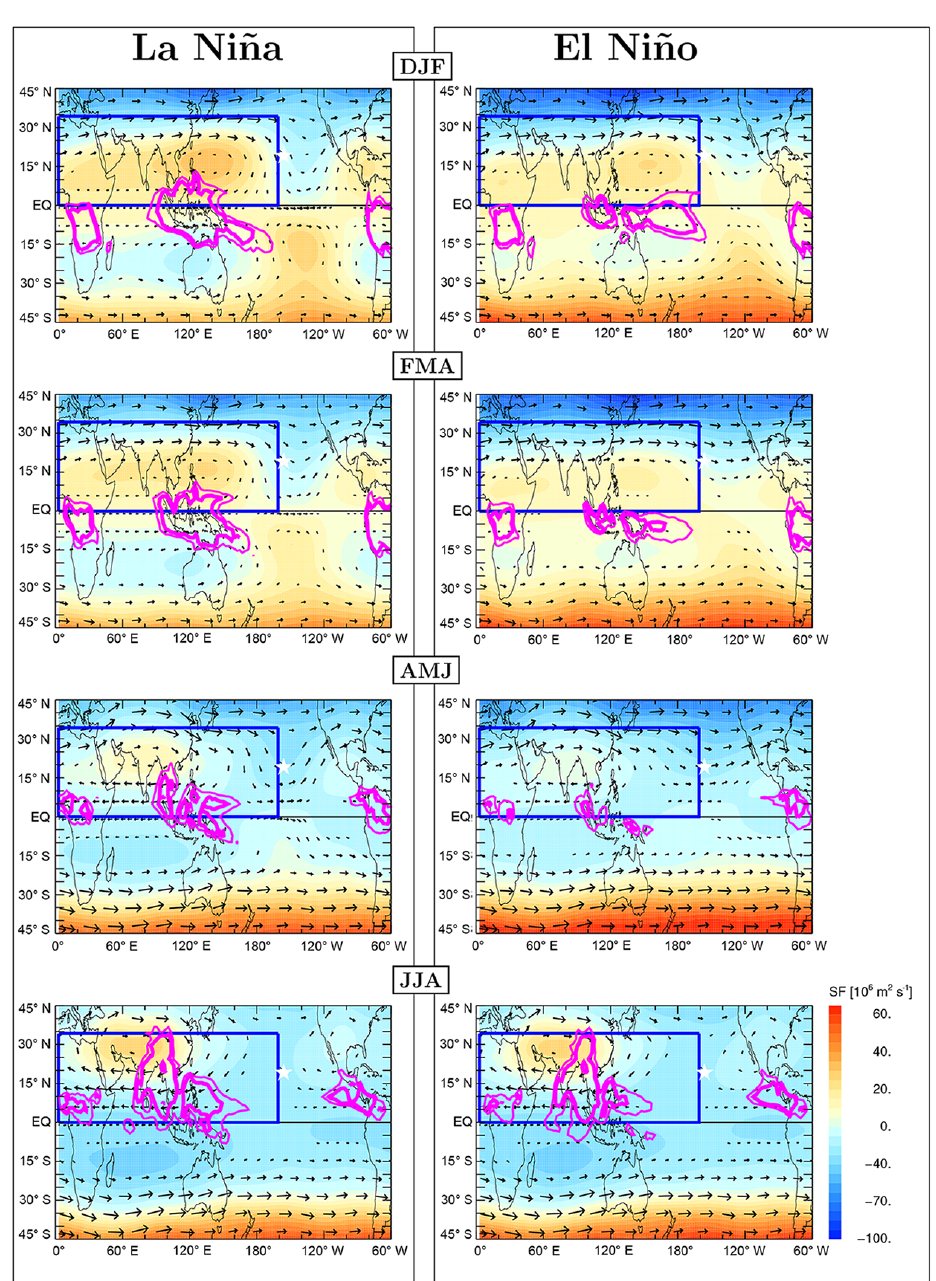
Figure 2. Climatologies (composites) of the stream function (SF, in 10 6 m 2 s − 1 ) at θ = 380K calculated from ERA-Interim (1979–2015) for months following La Niña (left) and El Niño (right) winters until summer (from top to bottom). The arrows represent the rotational horizontal wind. Magenta isolines indicate the strong convection regions based on OLR (thick and thin lines represent 210 and 220Wm − 2 contours). The blue rectangles mark the locations of strong anticyclone in NH (for details, see text). Hereafter, the star in the figure marks the location of the SHADOZ station (Hilo, Hawaii) where long-term ozonesonde observations are available (see Sect.